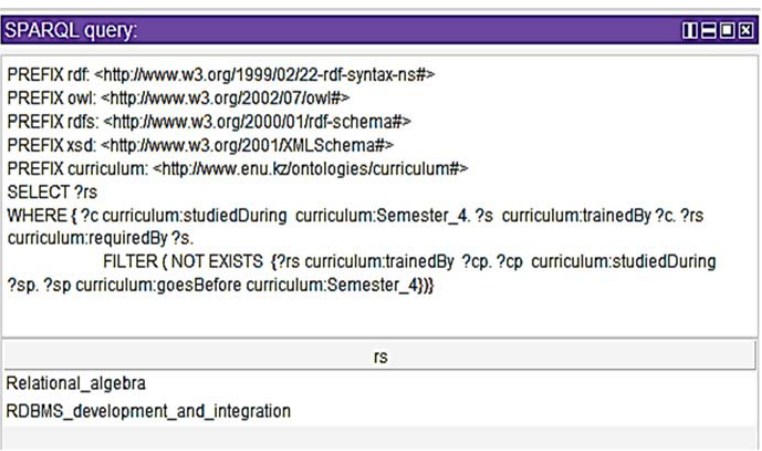
Figure 12. The list of skills that cause inconsistency in the educational programme in the 4th semester.